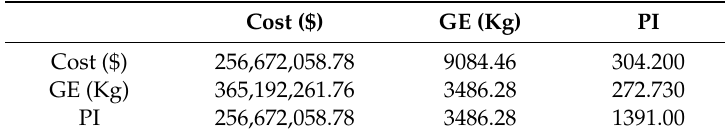
Table 17. Pay-o ff values of all objectives.